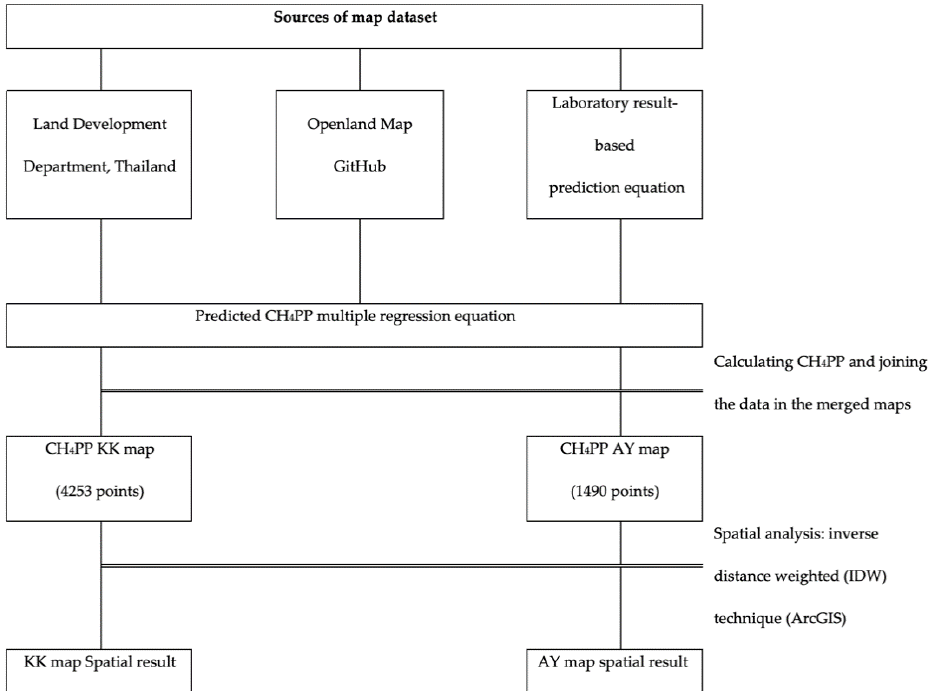
Figure 3. Workflow schematic of map spatial